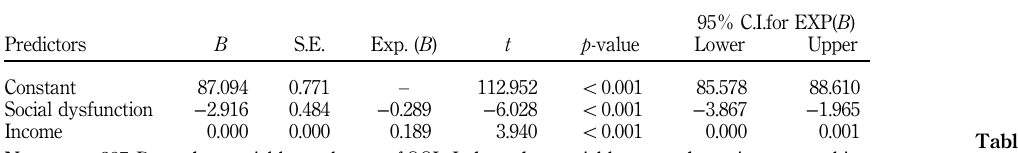
Table VII. Multiple regression analysis for predicting the